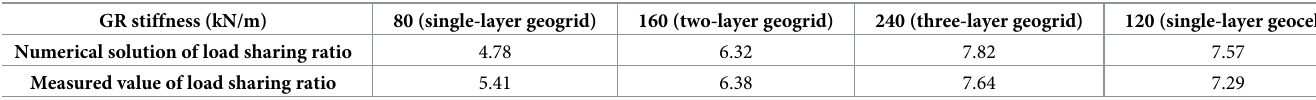
Table 6. Effect of GR stiffness on pile-soil sharing ratio.